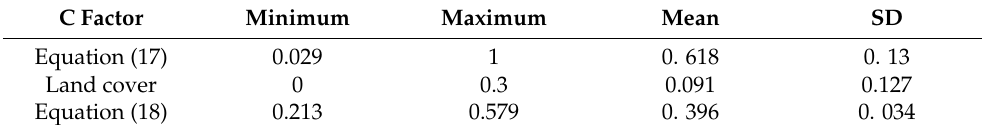
Figure 7. The very high C-factor values were distributed in the (A) landslide (B) and agricultural areas overlayed by the QuickBird image (R3:G2:B1). Table 10. C-factor parameters of the used models. Table 10. C-factor parameters of the used models.